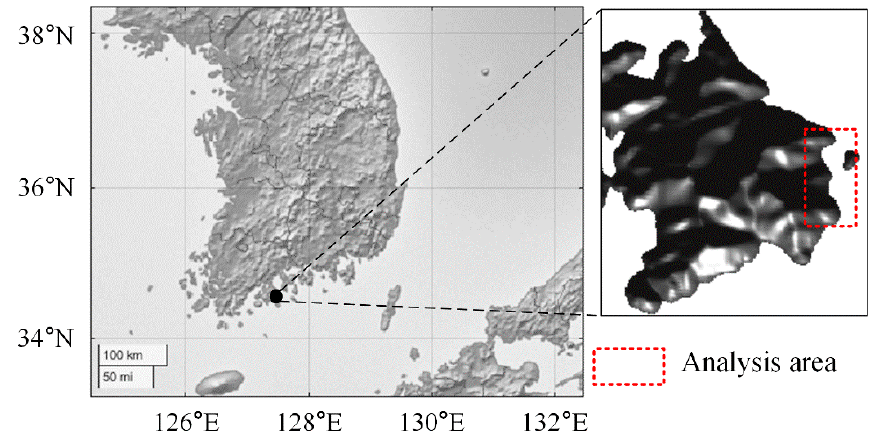
Figure 2. Location of the Naro Space Center and the analysis area.